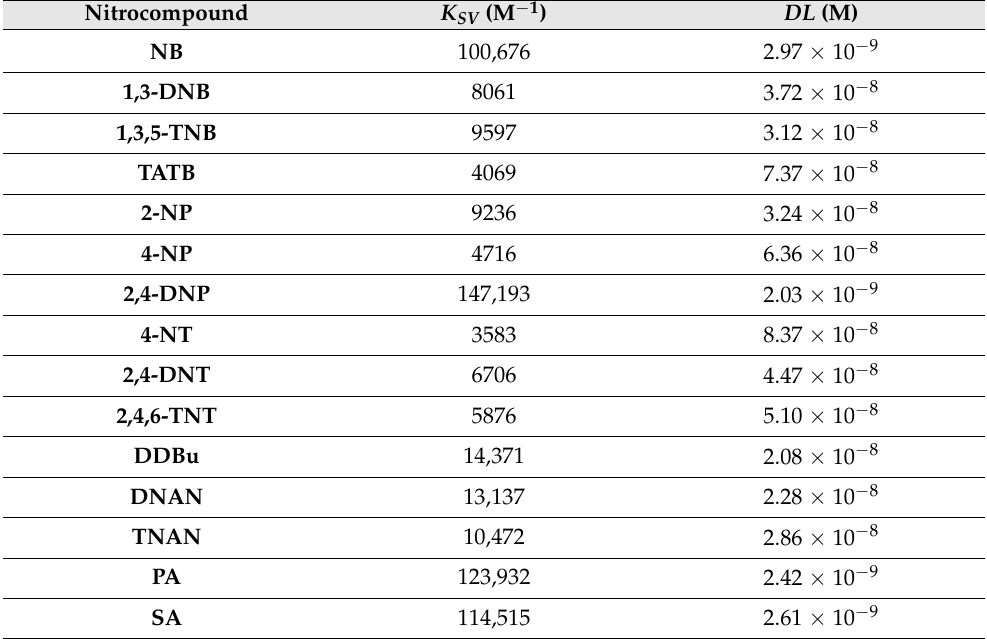
Figure 3. Quenching efficiencies of nitroaromatic analytes relative to fluorophore F at mM level in acetonitrile at the spectra peak wavelength of 447 nm. Table 1. Quenching constants ( K SV ) and detection limits ( DL ) of nitroaromatic analytes towards fluorophore F in acetonitrile solution.